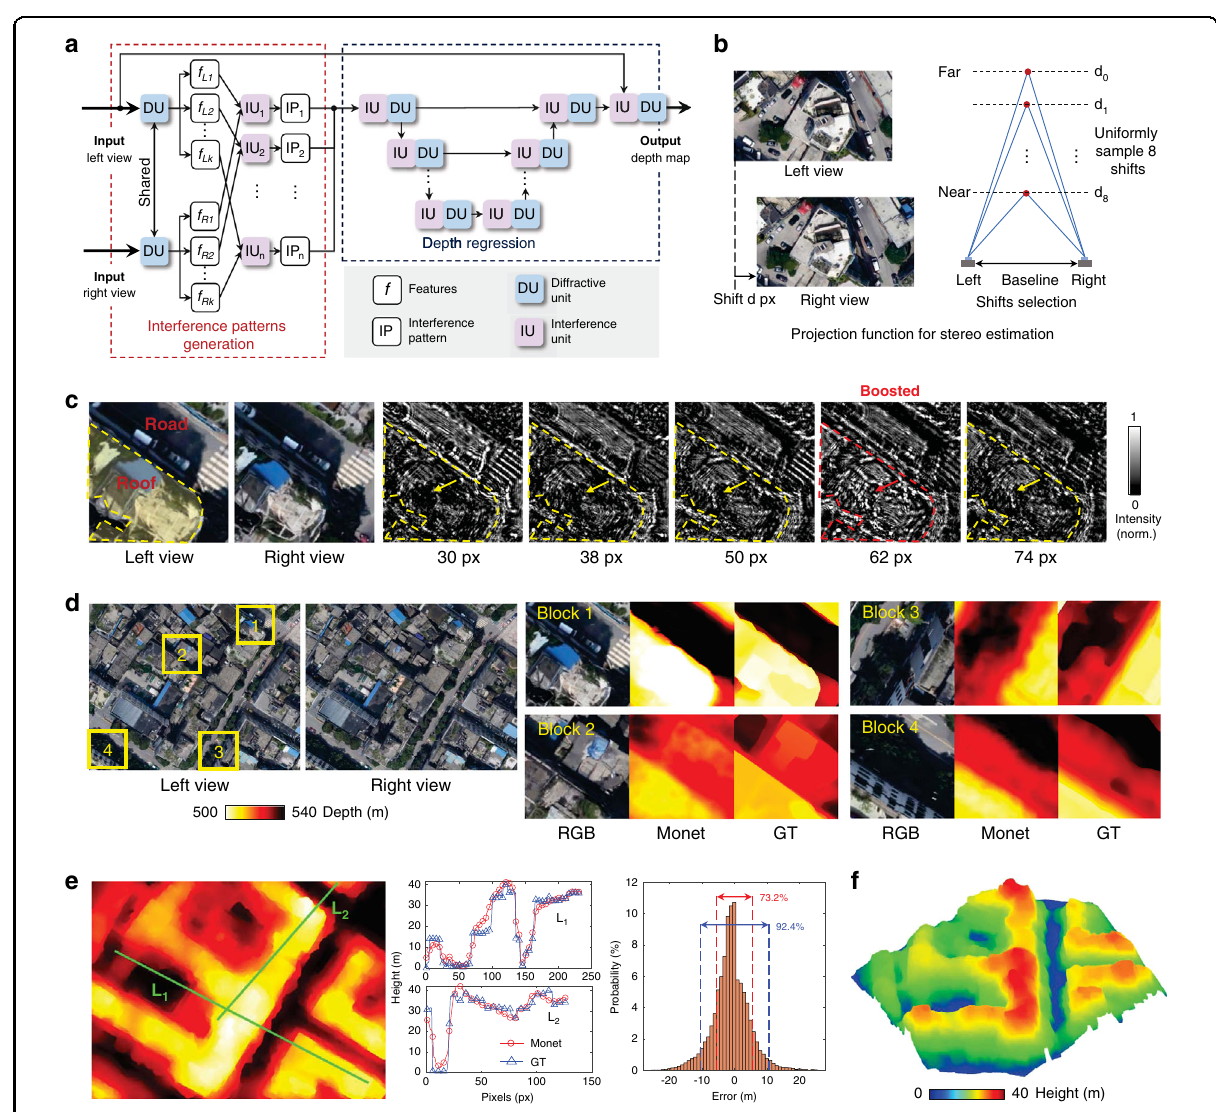
Fig. 2 Stereo depth estimation results. a Network architecture of the Monet for stereo depth estimation, composed of an interference pattern generation module followed by a depth regression module. The former module encodes the stereo correspondence into the interference patterns, and the latter module adopts a U-net-like structure to estimate the depth information from the patterns. b Projection function for stereo depth estimation. The spatial position of the left-view image is fi xed and the right-view image is shifted to the right according to the depth range. c Interference patterns with 5 shift distances (presented below each interference pattern). d A large area from the test set. Stereo depth estimation results of 4 representative blocks (labelled using yellow boxes) are shown on the right. e Stitched depth map of the large area in sub fi g. d The depth value is converted to the height relative to the ground for a more intuitive understanding. The heights along two lines L 1 and L 2 are presented in the middle. The depth-error distribution of the whole area is shown on the right. f Height-coloured 3d model of the large area. Norm normalized, GT ground-truth, px